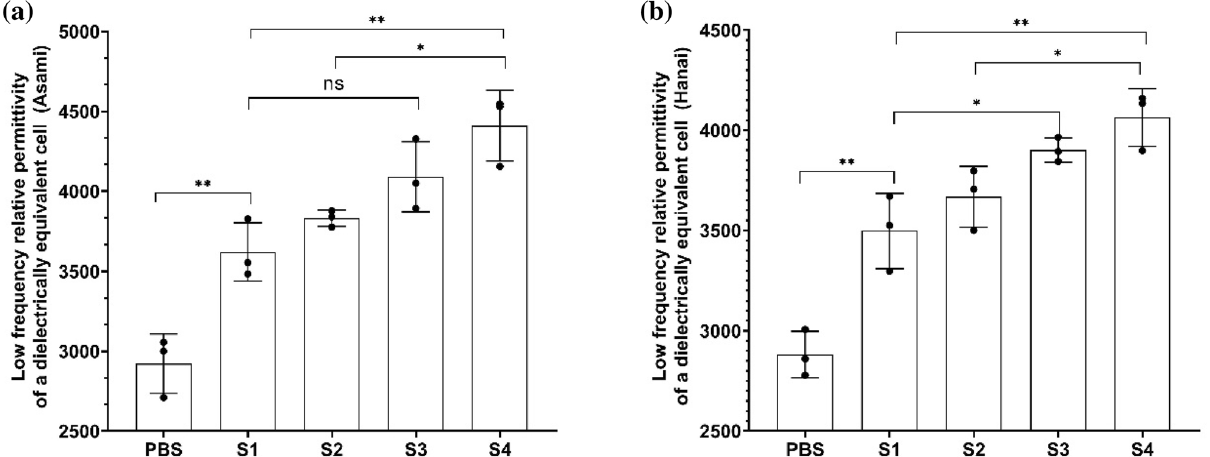
Figure 5. Comparison of ε c ,0 calculated using Asami’s approximation ( a ) and Hanai’s model ( b ). The data is computed using the experimental data from measurements with blood samples of varying HES concentration. Results are shown using box plots. One-way ANOVA with Tukey’s post-hoc test is used for multiple comparison. Probability values are indicated on figures by asterisks, as follows: *p < 0.05; **p <